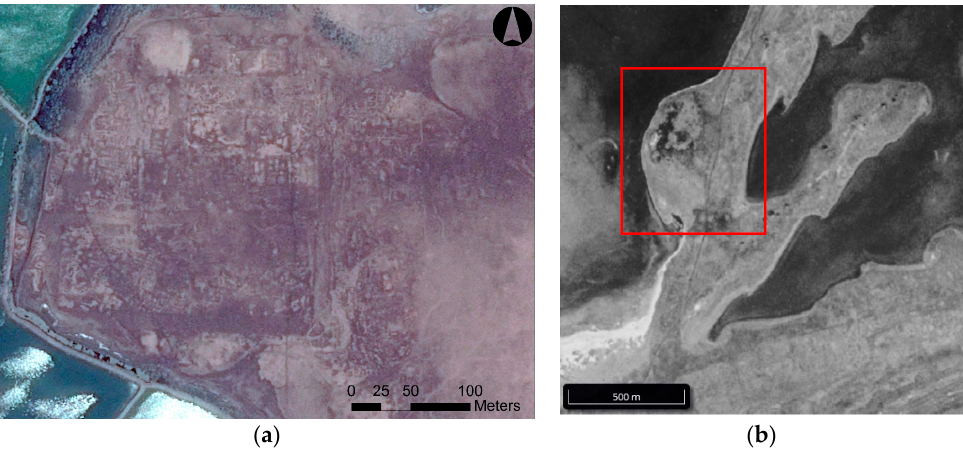
Figure 17. ( a ) The site of Tell Belim. Image courtesy Google Earth; ( b ) 1968 CORONA image. The area of image ( a ) is in the red box. Image courtesy of the Center for Advanced Spatial Technologies, University of Arkansas/U.S. Geological Survey.